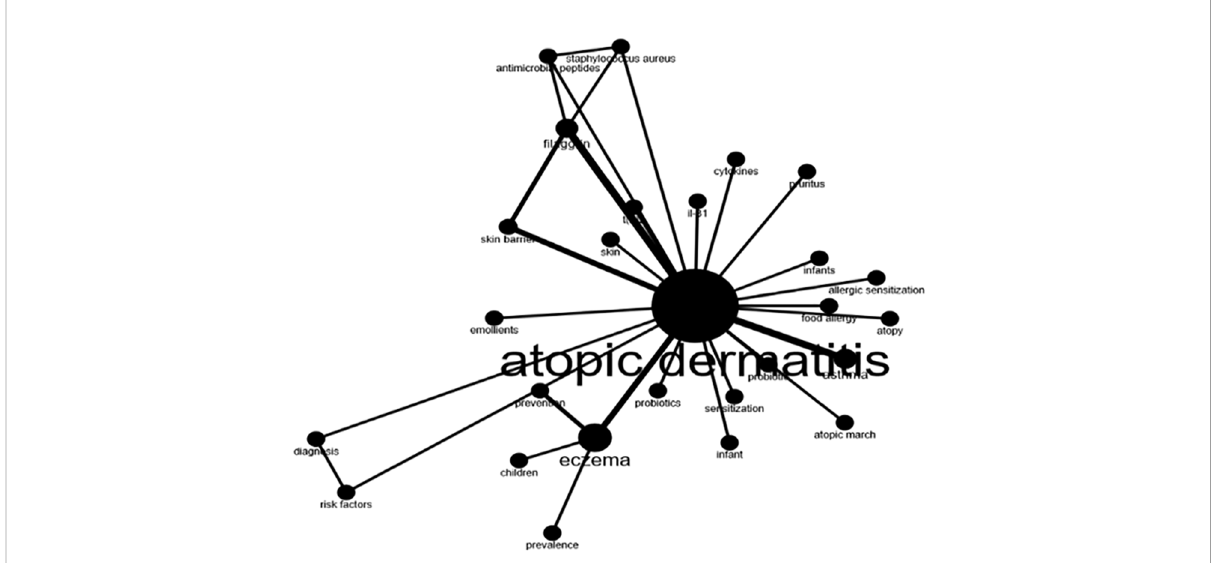
FIGURE 4 A co-occurrence networks. Thick lines indicate a strong relationship between those keywords. Thin lines represent weak association. Keywords without connecting lines indicate that no relationship has been